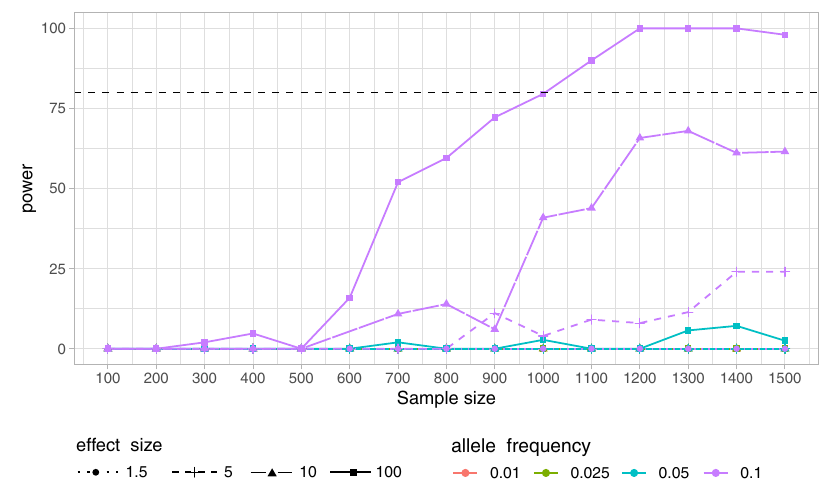
SNPs (variant GWAS) and mutated genes (burden testing GWAS) causing binary phenotypes. Table 2 and Supplementary Fig. 1 show the sample sizes required to detect causal acquired genes with 80% power in a pan-genome GWAS. These sample sizes are comparable to those obtained by the sub-sampling approach for the detection of acquired AMR genes (Supple- mentary Table 1). Speci fi cally, a minimum of 500 – 600 genomes